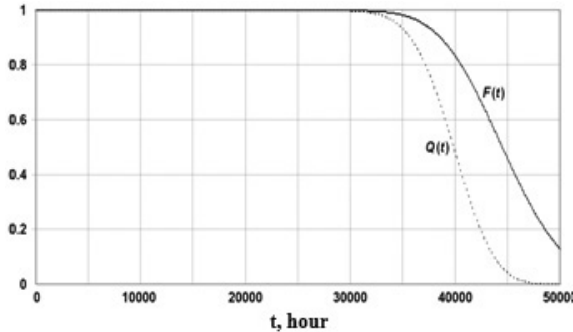
Figure 2. Probability of failure-free operation of the quadrant F ( t ) and the coolant flow rate measurement system Q ( t ).